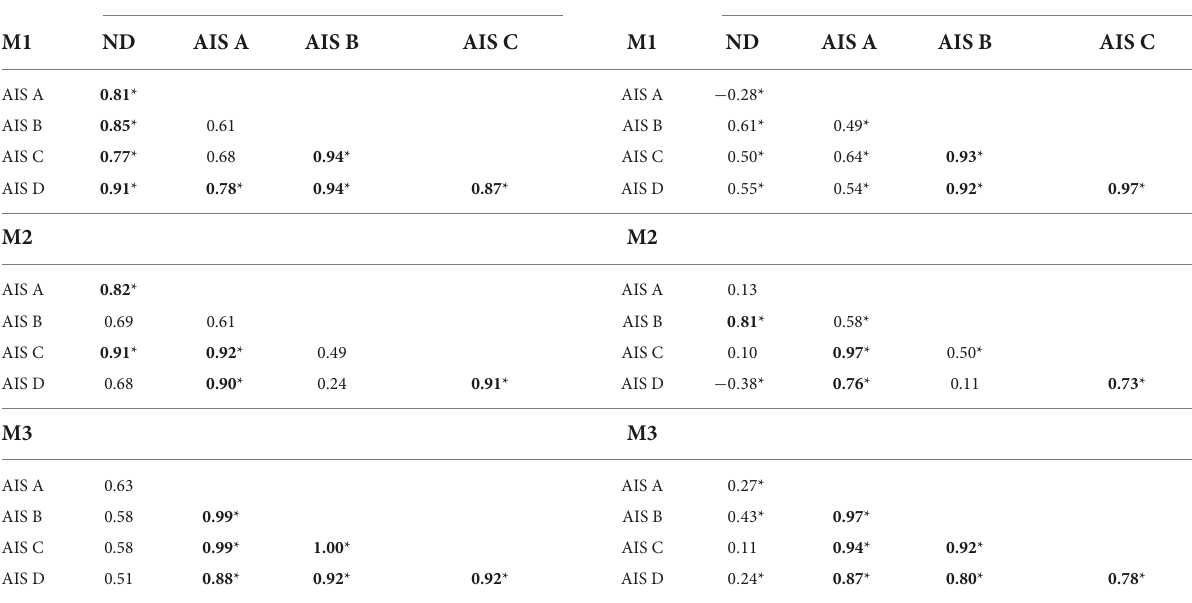
TABLE 2 Correlation of SF-NMF 3-module patterns among ND and AIS groups. Correlation of spatial patterns Correlation of temporal